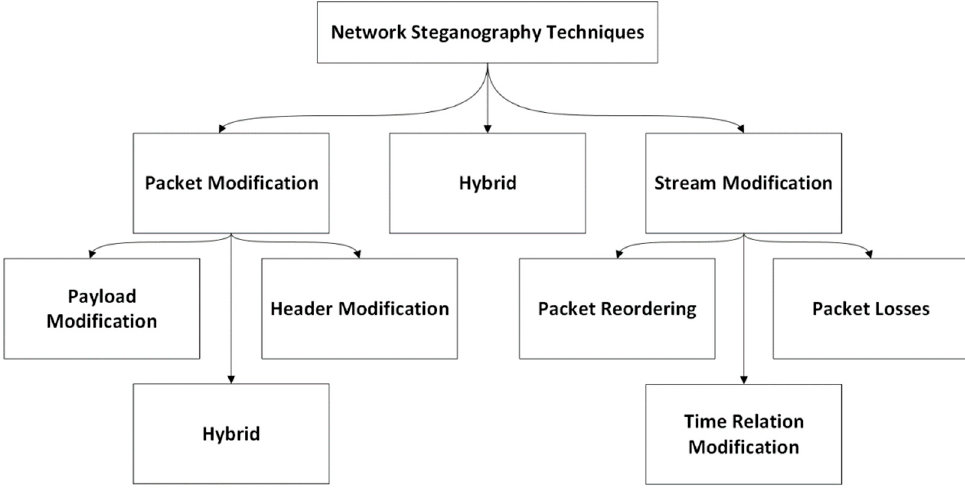
Figure 2. Network steganography classification.